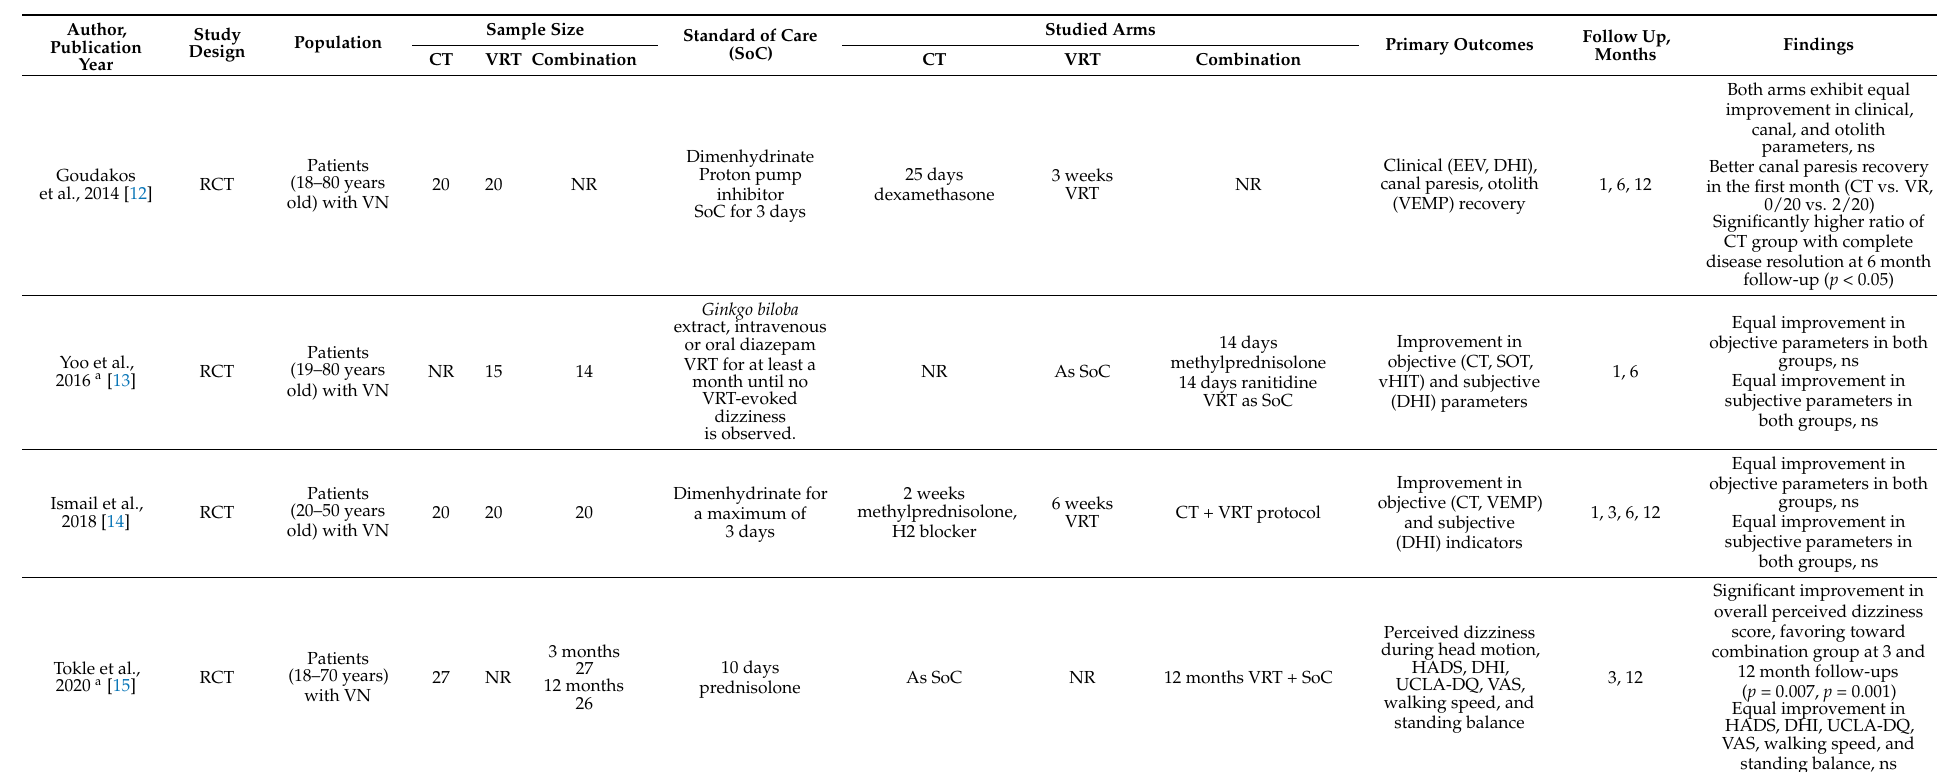
Table 1. Characteristics and Findings of Involved